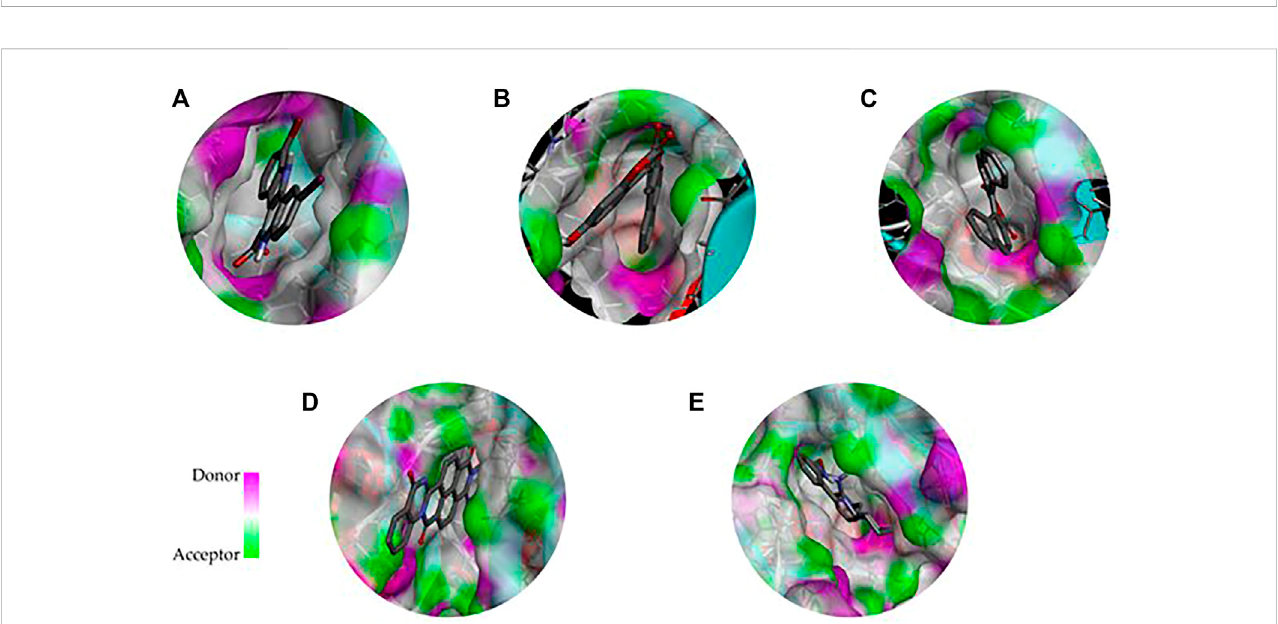
FIGURE 4 3Drepresentationofthebindingcavityofthecontrolandtop-rankedmoleculestothepocketsiteofDYRK1A.Pinkandgreencolorsre fl ectthehydrogen bond donor and acceptor, respectively; (A) 4E3 control, (B) ZINC3843365, (C) ZINC2123081, (D) ZINC5220992, and (E) ZINC68569602.